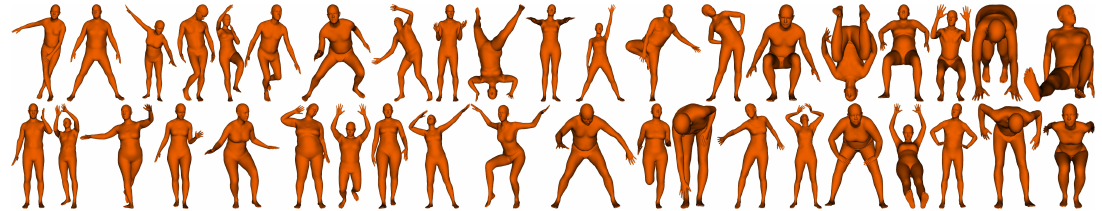
Figure 10. Some representative human poses with different subjects in our HPRD